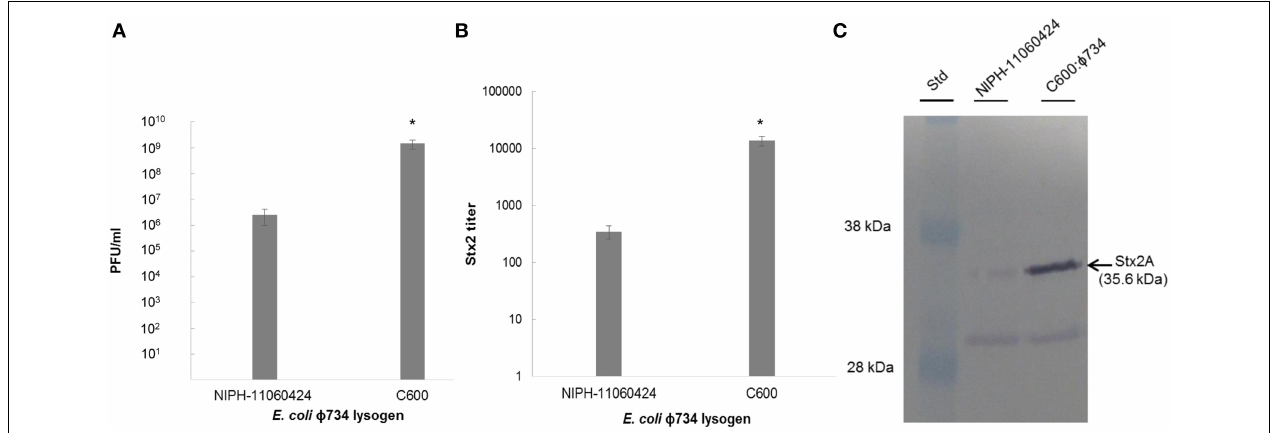
FIGURE 3 | Phage production and Stx2 expression by NIPH-11060424 and E. coli C600: φ 734 after MMC induction. (A) Phage production measured as plaque forming units. (B) Stx2 titer measured by reverse passive latex agglutination. (C) Stx2 production visualized by Western blot.